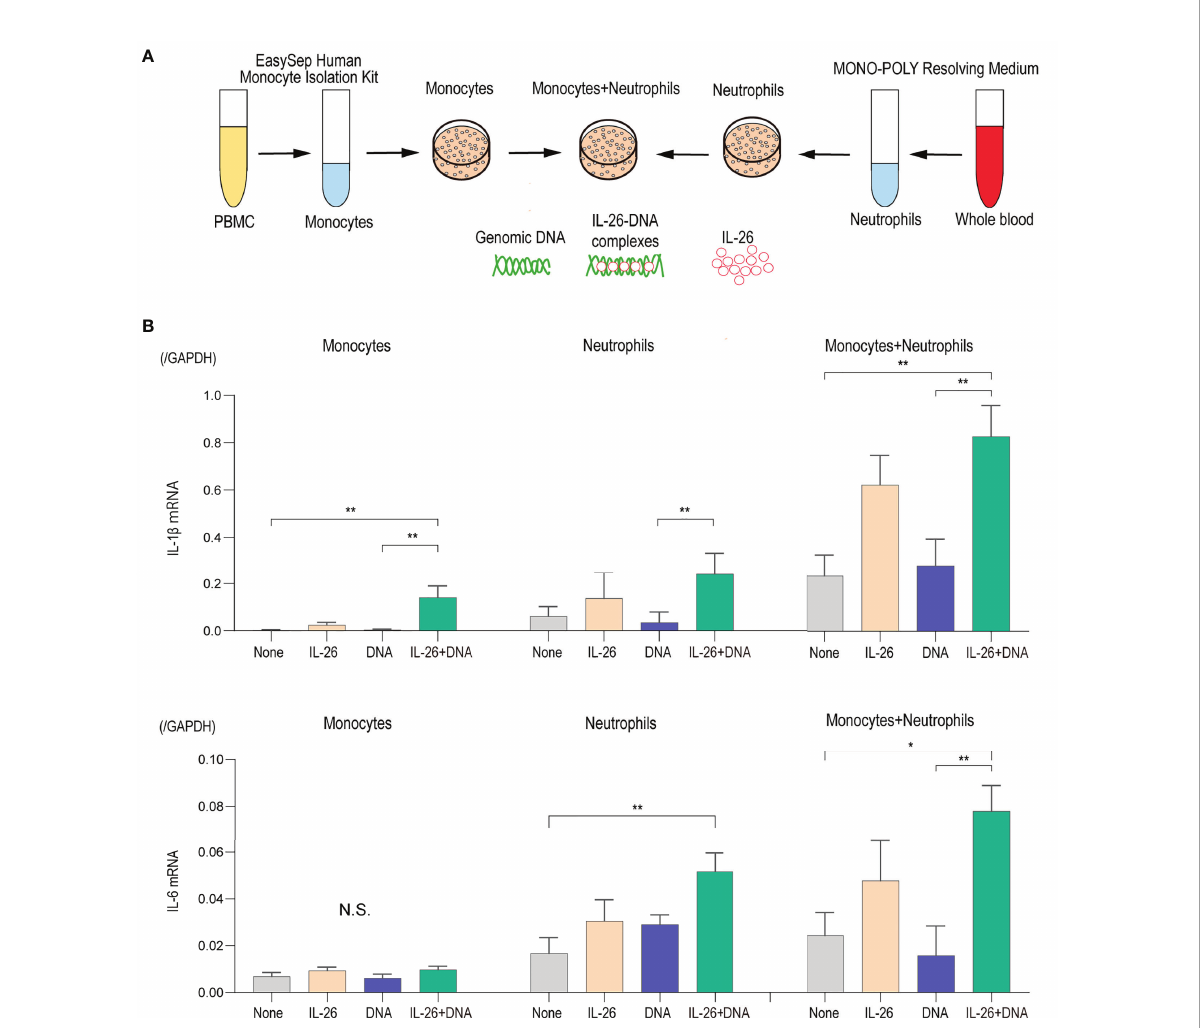
FIGURE 4 IL-26 synergizes with DNA in inducing proin fl ammatory cytokines (A) Experimental design of the isolation and culture of human monocytes and neutrophils. (B) Gene expression levels in monocytes alone, neutrophils alone, and co-cultured monocytes and neutrophils. Cells were stimulated with/without 50 ng/mL of IL-26 and 10 µg/mL genomic DNA or with IL-26 – DNA complexes for 6 hours. The relative mRNA expressions of IL-1 b and IL-6 were evaluated by quantitative real-time PCR. The results shown are representative of fi ve independent experiments with similar results. Data are presented as mean ± SD. * p < 0.05 ** p < 0.001. N.S., Not signi fi